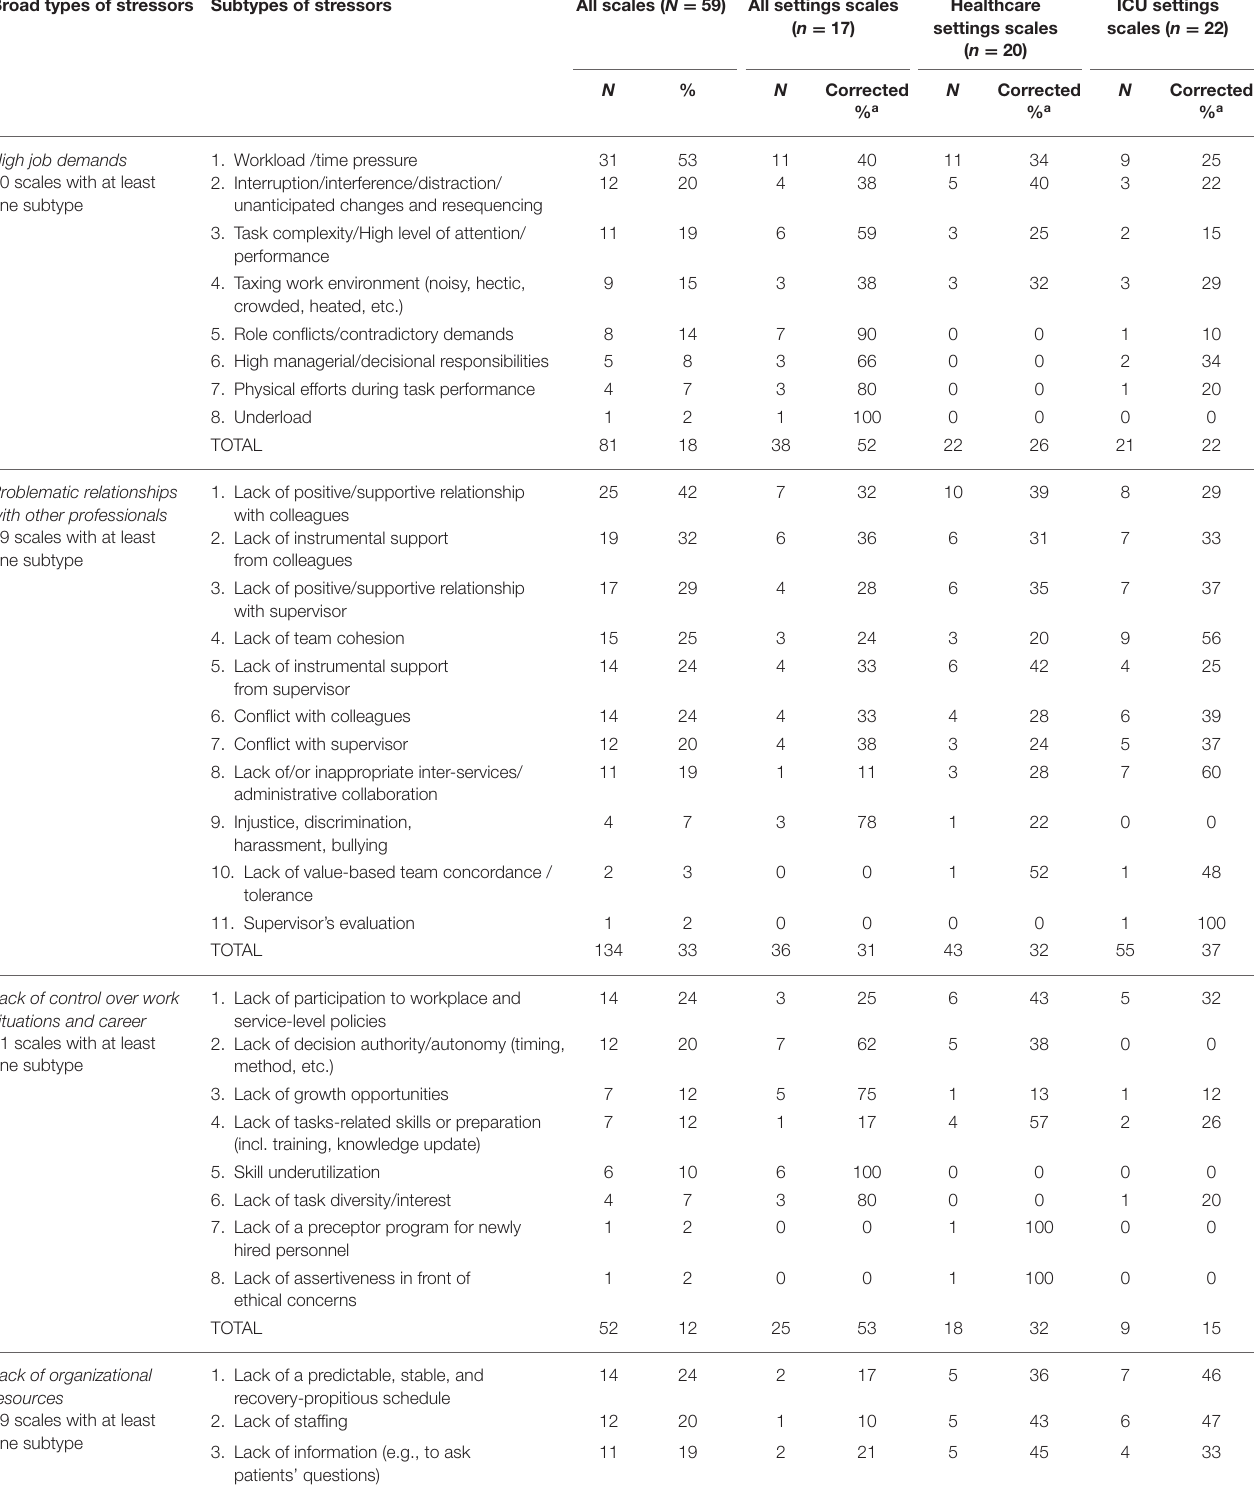
TABLE 2 | Broad types and subtypes of stressors measured by each type of scales used in ICU studies. Broad types of stressors Subtypes of stressors All scales ( N = 59) All settings scales